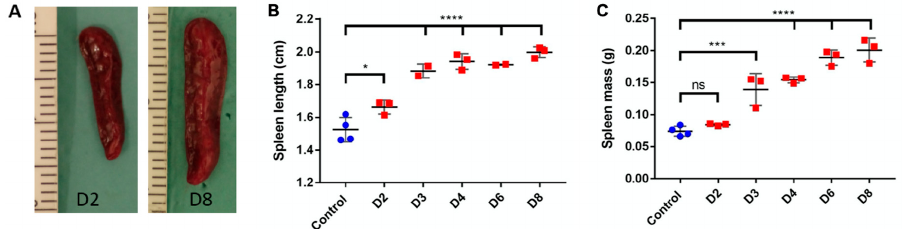
Figure 9. Evaluation of spleen length and mass in the course of IMQ-induced psoriasis-like dermatitis. Visual examination shows increased length and width of the spleen between days 2 and 8 ( A ). Spleen length ( B ) and mass ( C ) evaluations were analyzed using one-way ANOVA followed by Dunnett multiple comparison test. Values are presented as mean ± SD ( n = 3, except for control where n = 4). *: p < 0.05, ***: p < 0.0005, ****: p < 0.0001. Pharmaceutics 2020 , 12 , x FOR PEER REVIEW